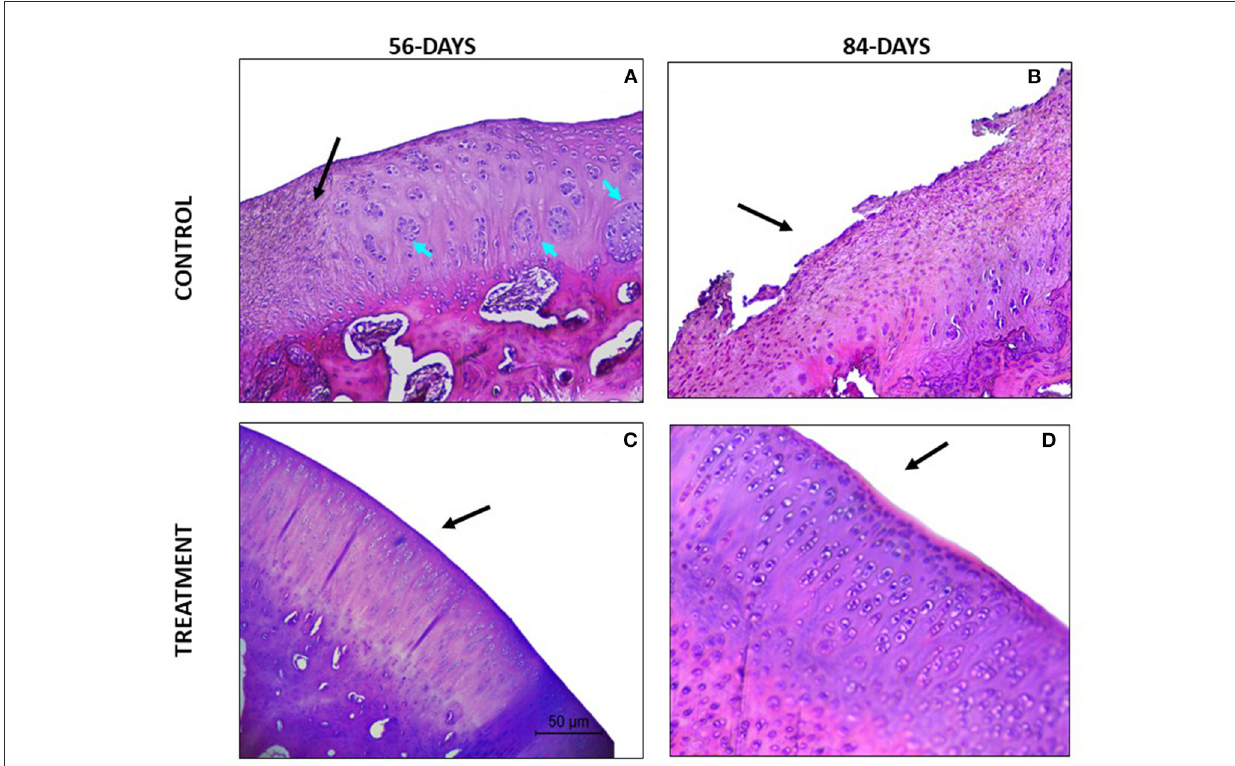
FIGURE7 Hematoxylin-Eosin stained sections. (A) The defect area is being filled with fibrocartilage-like tissue (black arrow). Additionally, big chondrocytes clusters are present (blue arrows). (B) Defect filled with fibrocartilage-like tissue. (C) Good regeneration tissue, hyaline like appearance. Some areas with low chondrocyte density can be identified. (D) High chondrocyte density, all of them forming columns. The tissue is comparable to healthy hyaline cartilage.